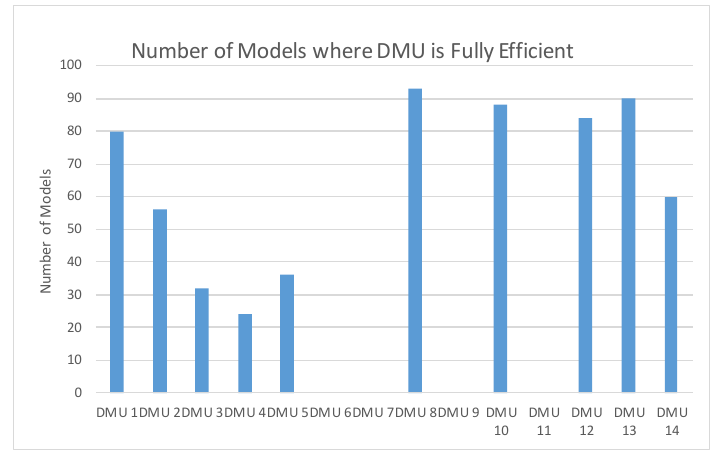
Figure 3. Number of times a DMU is fully efficient in Ensemble CCR models.